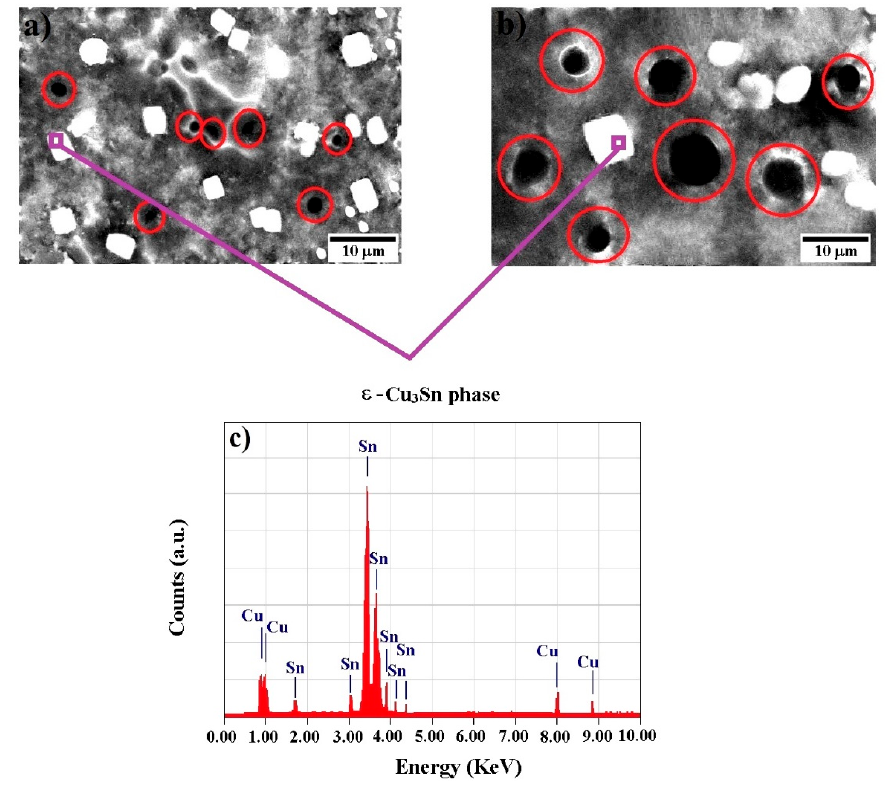
Figure 6. ( a ) SEM image of SZ-4Cu alloy aged at 323 K, ( b ) SEM image of SZ-4Cu alloy aged at 398 K, ( c ) EDS spectrum of ε -Cu 3 Sn